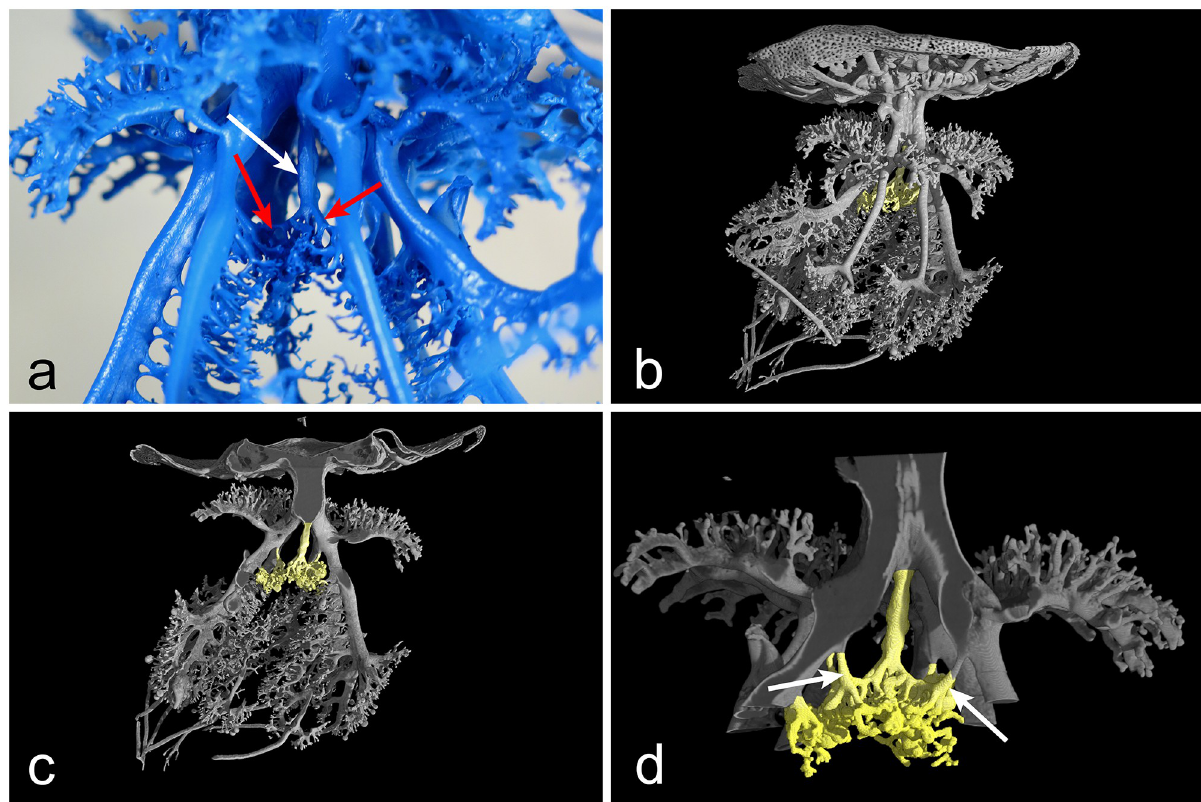
Fig 6. Morphology of the manubrium gastrovascular system. (a) Proximal internal region of the manubrium, showing the projection of the juvenile central mouth (white arrow), distally branching into a series of small canals with terminal openings (red arrows). (b) Volume rendering obtained by X- ray μ CT showing the hidden central canal and its branches (yellow). (c) Longitudinal section of the volume shown in (b), highlighting two lateral canals connected with two oral arms. (d) Magnification of the region showed in (c), featuring all the four transverse connections with the proximal bifurcations of the emerging eight oral arms (arrows indicate two of them). CT reconstruction performed with an isotropic voxel size of 62.0 μ